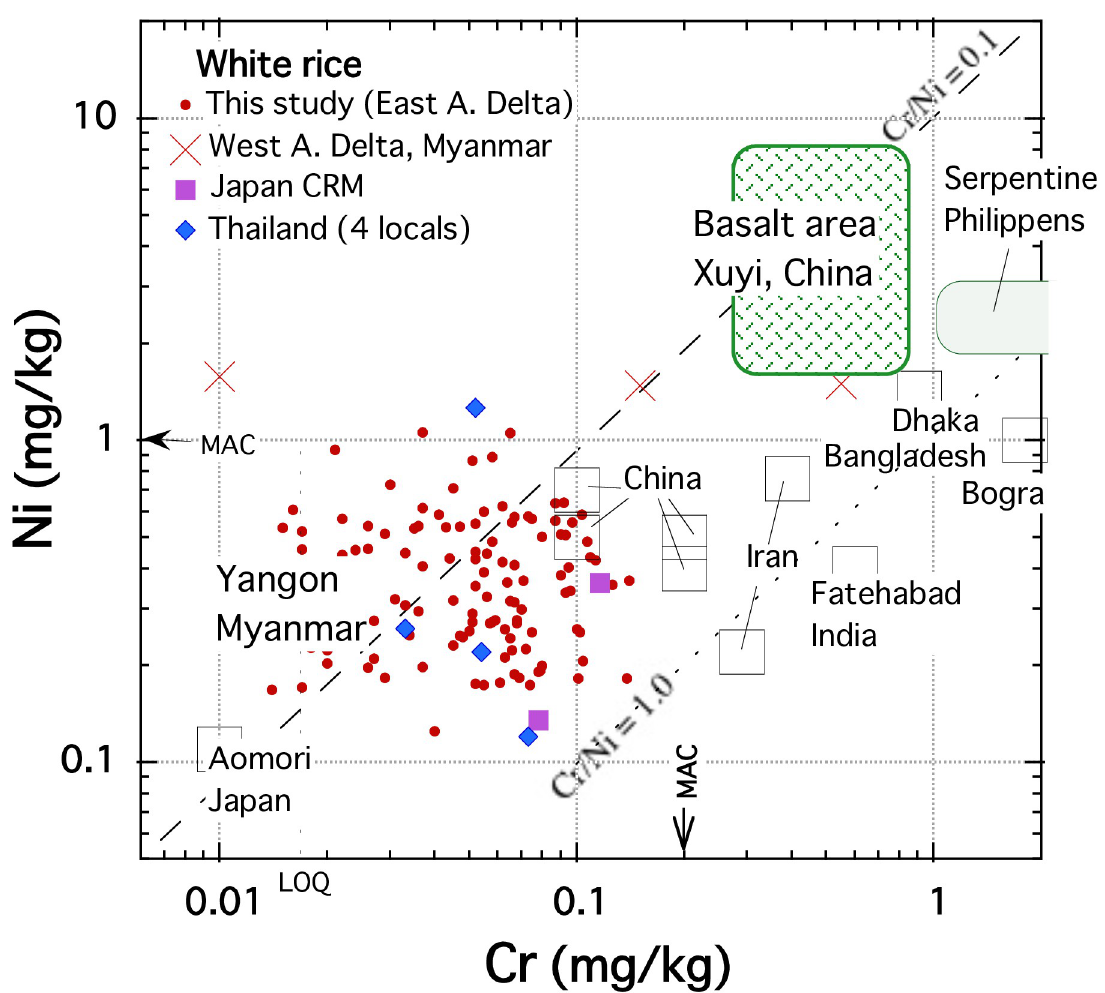
Fig 5. Correlation diagram between Ni and Cr concentrations in white rice from different countries and areas. Japan certified reference materials (CRM) data are from S2 Table. The mean values or the level ranges of previous reports: West Ayeyawady delta in Myanmar [20, 21]; Japan certified reference materials (NMIJ CRM 7501-a and 7502-a; S2 Table) Xuyi, China [18]; Shengzhou, Shimen, Fenghuang, and Xiangtan, in China [47, 48]; Bangladesh [49, 50]; Iran [51, 52]; Four local areas in Thailand [10]; Zambales, Philippines [73]; Fatehabad, India [74]; Aomori, Japan [75]. Incidentally, Aomori has one of the lowest population densities in